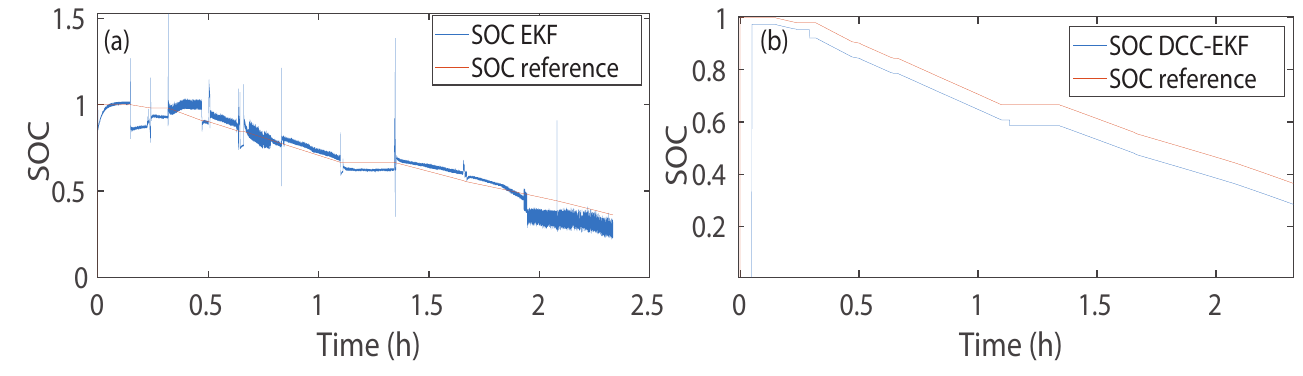
Figure 8. Results of the variable current discharge test: ( a ) SOC comparison between SOC ref and ˆ SOC with Extended Kalman Filter, and correct parameter initialization [22]. ( b ) SOC comparison between SOC ref and ˆ SOC with Dual Coulomb Counting Extended Kalman